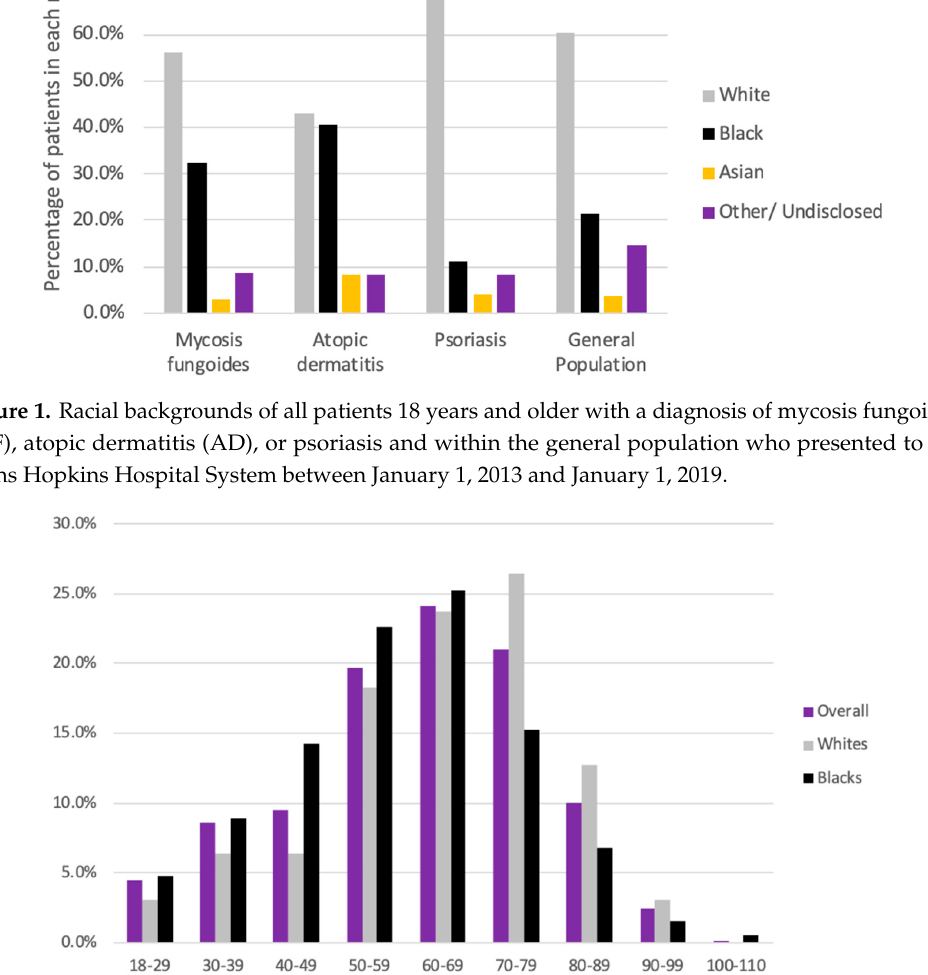
Figure 2. Age distribution of patients with mycosis fungoides (MF) overall, in black and in patients.